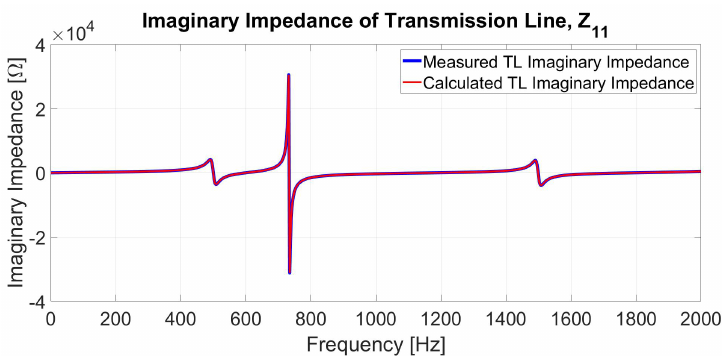
Figure 10. Frequency response measurements and the proposed model calculation of transmission line imaginary impedance ( Z 11